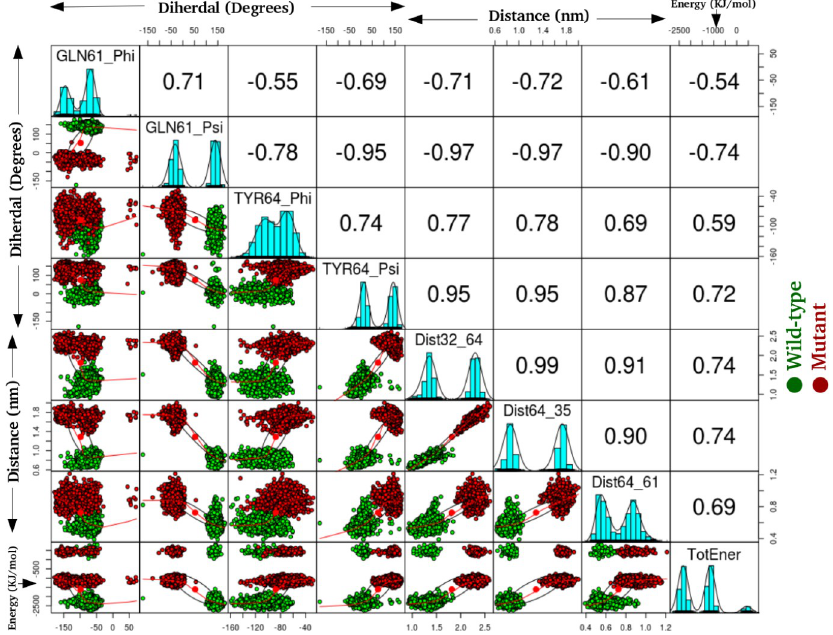
Fig 8. The 2-D plot showing the projections of wild-type (green) and mutant (red) trajectories, using multivariate PCA approach. A combination of dihedral, interactions and energy were used as features, as labelled on the X and Y